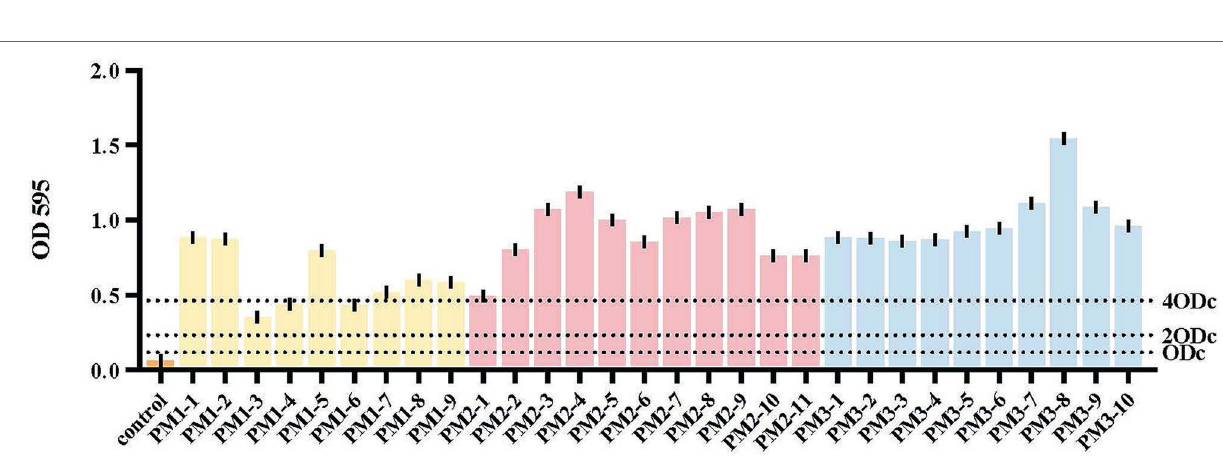
FIGURE 2 | Biofilm formation. Yellow, PM1; pink, PM2; blue, PM3. The cut-off value (ODc) was defined as 3 SD above the mean OD 595 of the negative control: ODc = average OD 595 of negative control + (3 × SD of negative control). OD 595 ≤ ODc = absence of biofilm; ODc ≤ OD 595 ≤ 2 × ODc = weak biofilm producer; 2 × ODc ≤ OD 595 ≤ 4 × ODc = moderate biofilm producer; 4 × ODc ≤ OD 595 = strong biofilm